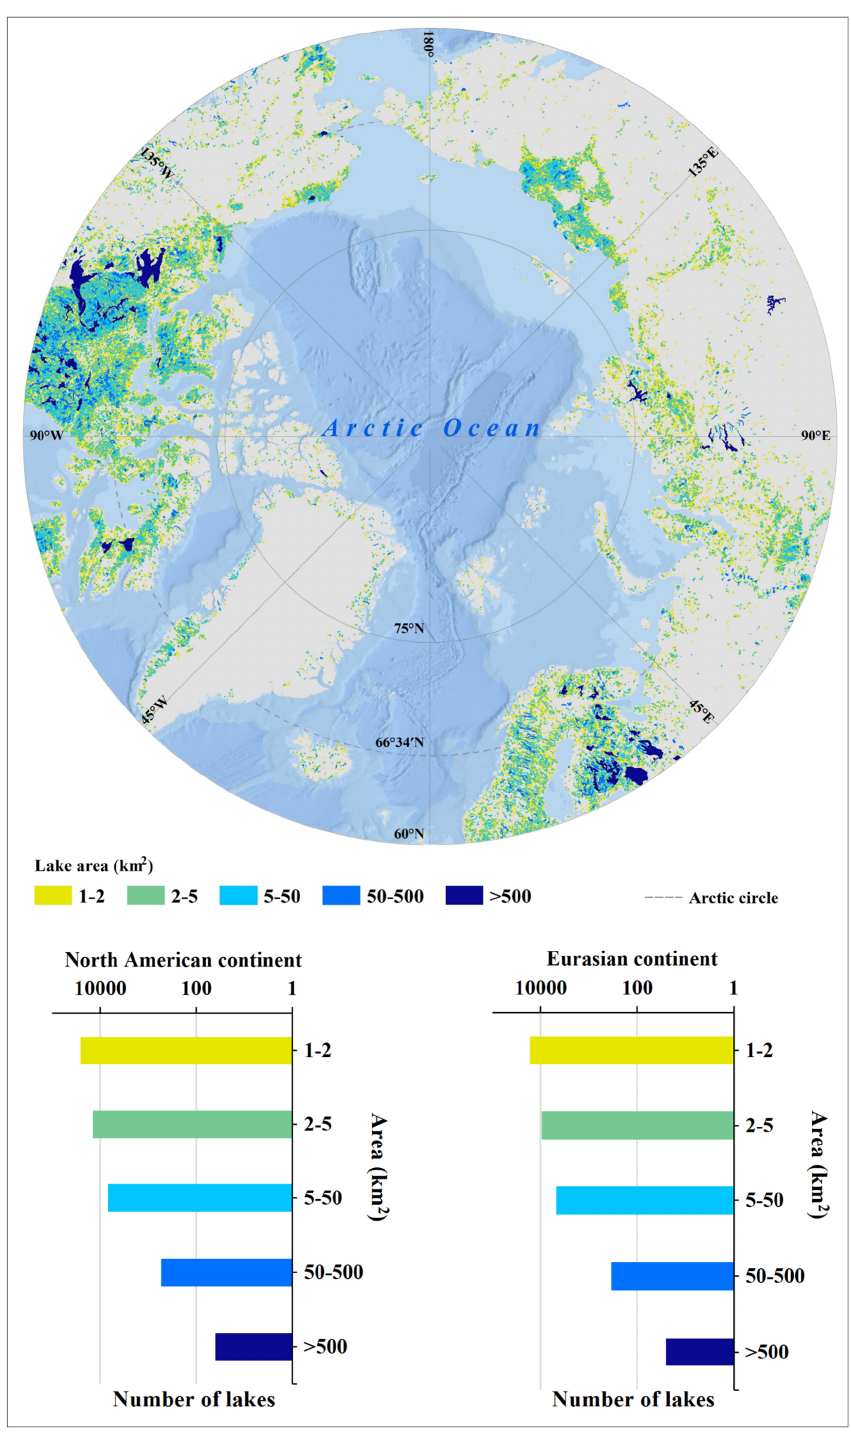
Figure 1. Global distribution of pan-Arctic lakes observed by the ICESat-2 in the HydroLAKES